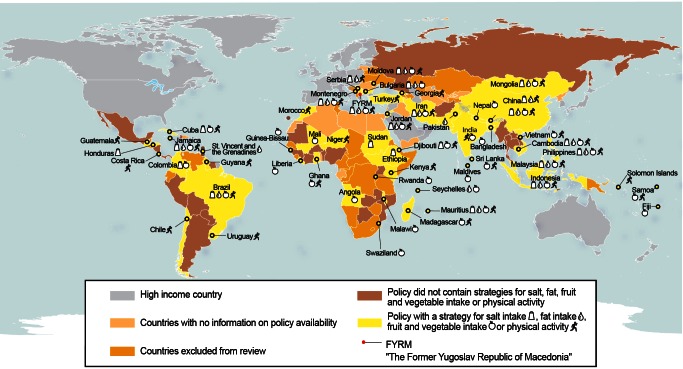
Atlas of availability of national actions to limit salt or fat intake or increase fruit and vegetable intake or physical activity.Geographic boundaries from the United Nations Cartographic Section were used [105].